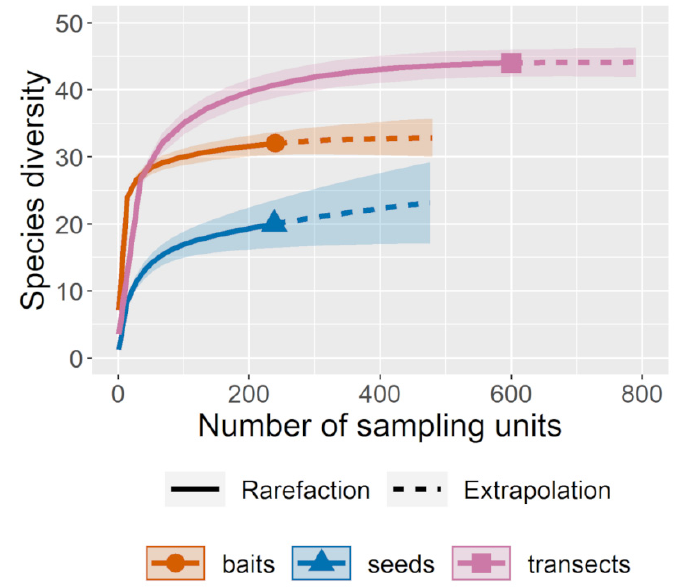
Figure 2. Ant species richness accumulation and extrapolation by sampling type: leaf litter quadrats, tuna–honey bait recruitment, and seed bait removals.